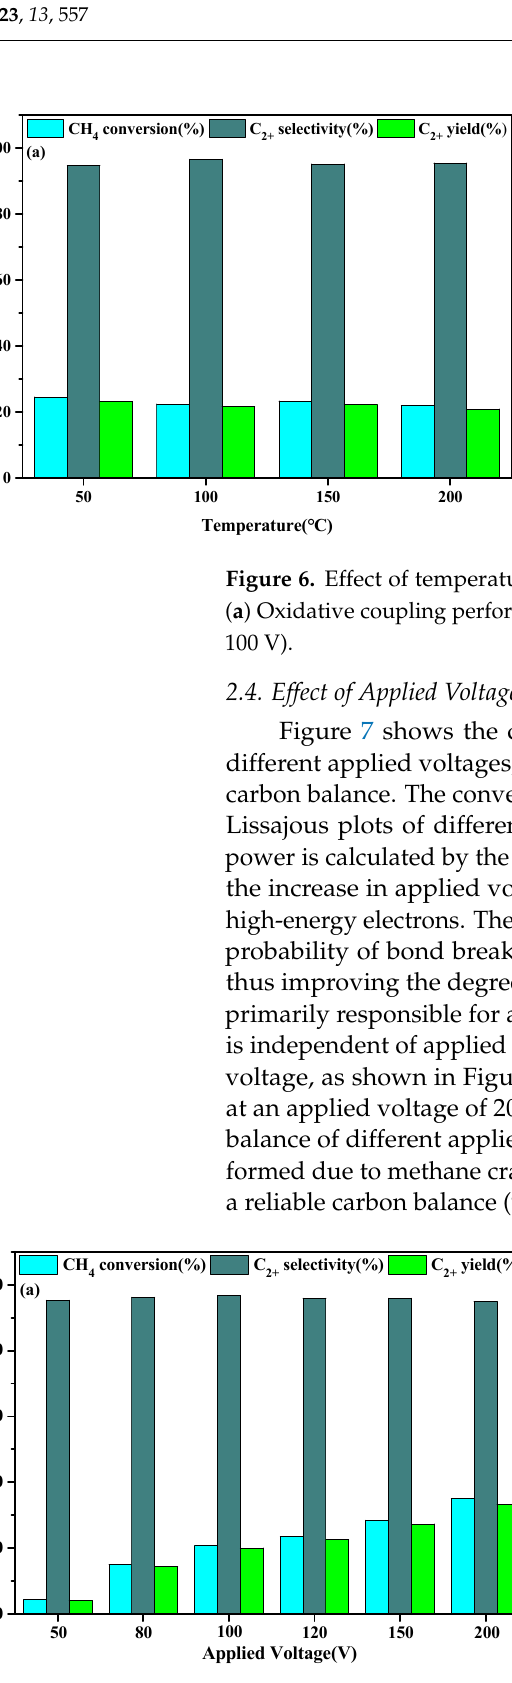
Figure 8. Lissajous plots of different applied voltages on the MnTi catalyst.